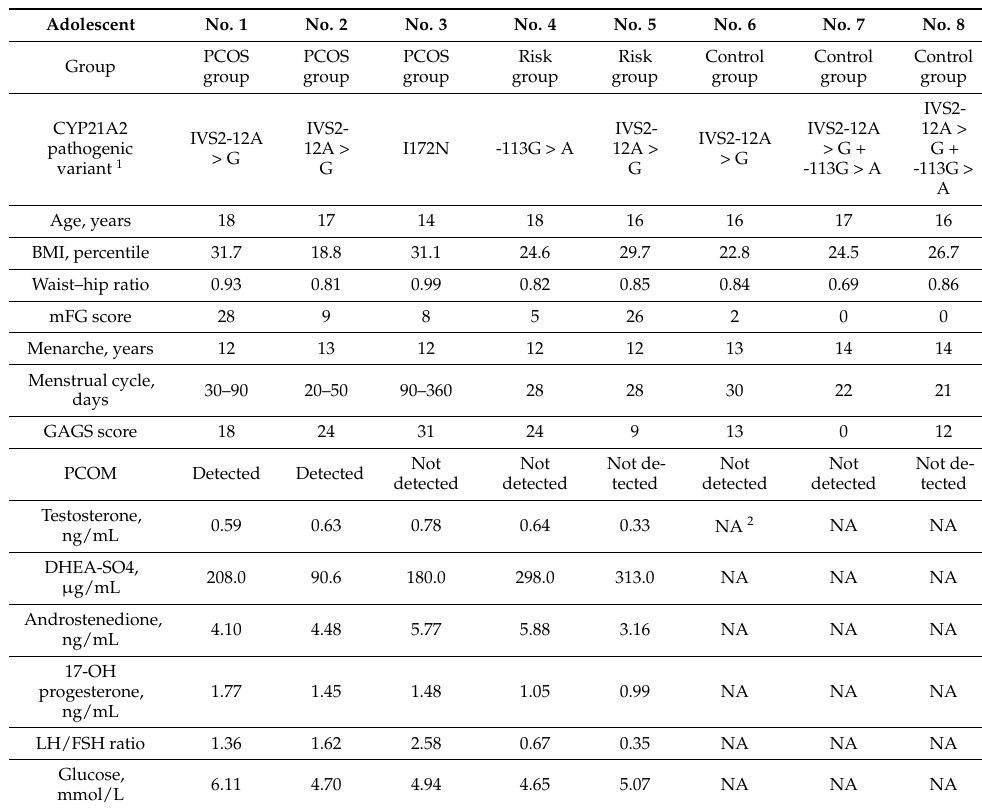
Table 3. Characterization of each individual with an identified